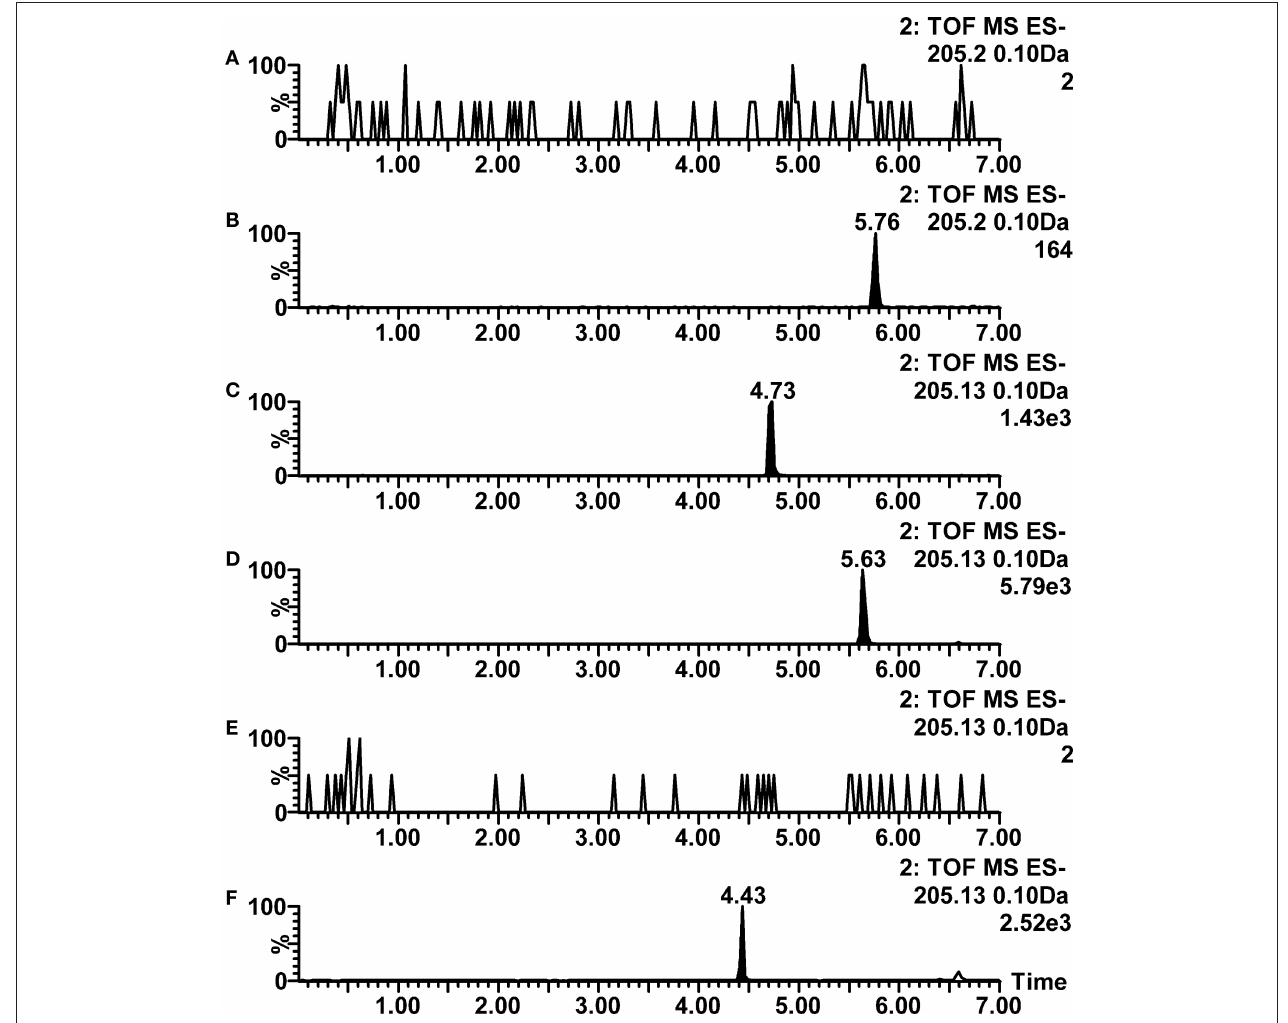
FIgurE 3 | Negative ion mode LC–ESI–TOF–MS ion chromatograms for ibuprofen at various mobile phase pH conditions. (A) 0.1% formic acid (pH 2.8); (B) 0.1% acetic acid (pH 3.2); (C) 2 mM ammonium formate (pH 6.0); (D) 0.05% acetic acid with 5 mM ammonium acetate (pH 4.4); (E) 2 mM ammonium acetate (pH 6.7); (F) 10 mM ammonia (pH